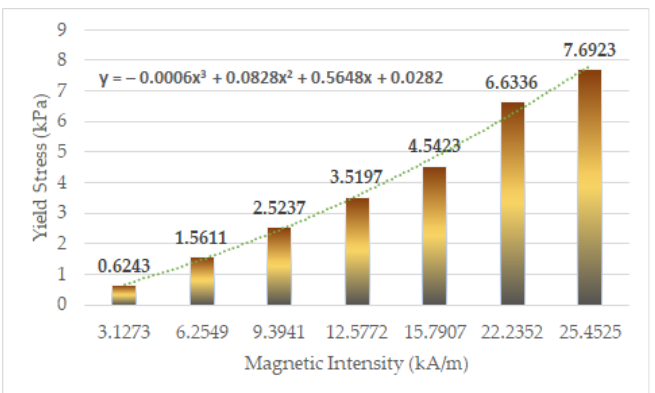
Figure 9. The relationship between the yield stress and magnetic field achieved from the magnetic field analysis ( 𝜏(𝑦) − 𝐻) . Table 1. The calculated values of H and yield stress generated from the effective area of